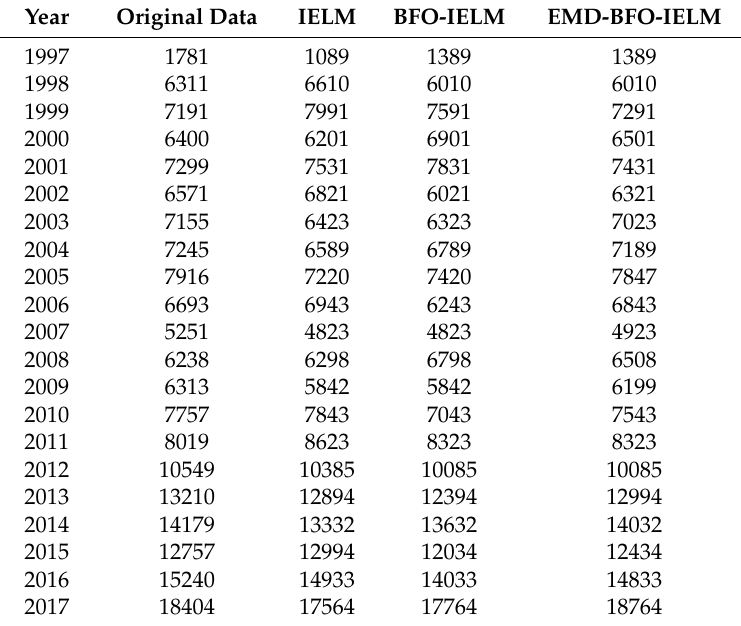
Table A2. The forecasting results of 3 intelligent machine